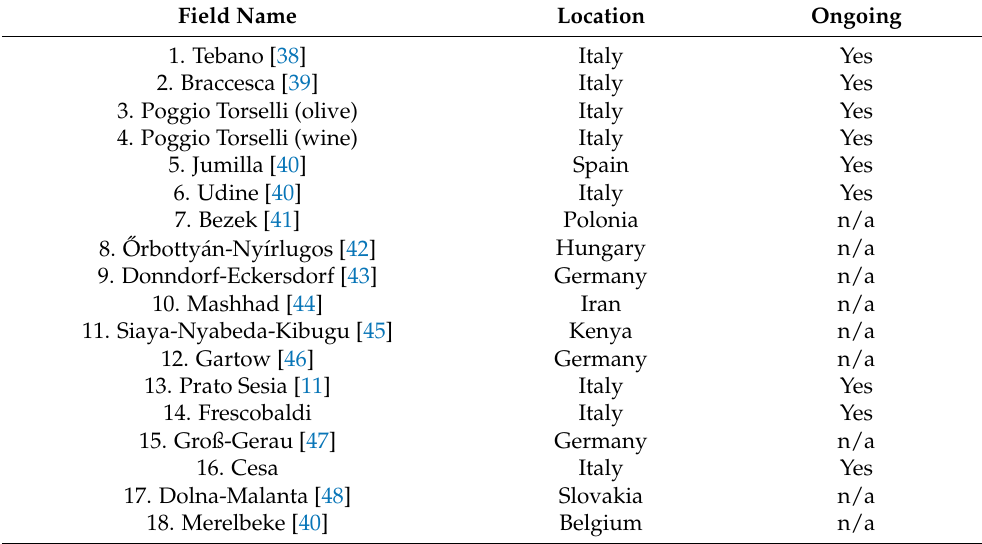
Table 3. Long-term experiments currently included in LTEP-BIOCHAR platform. (The abbreviation n/a indicates that the researchers have not confirmed the experiment’s